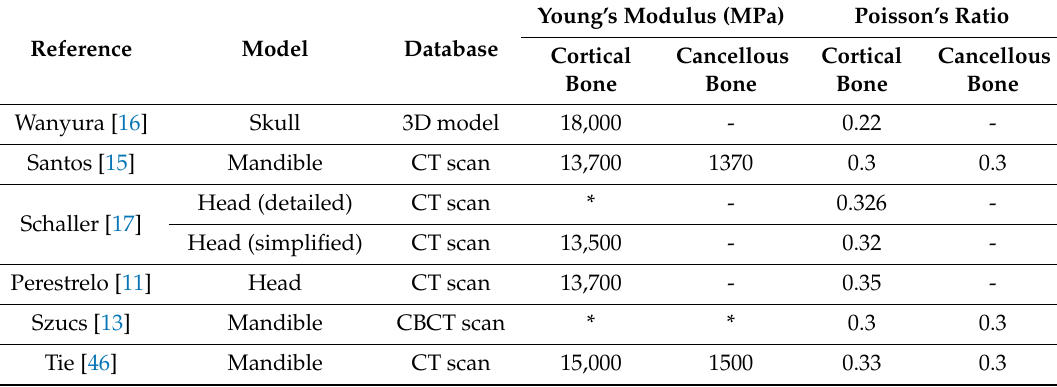
Table 5. Models and material properties used in FEA of trauma to the maxillofacial region.